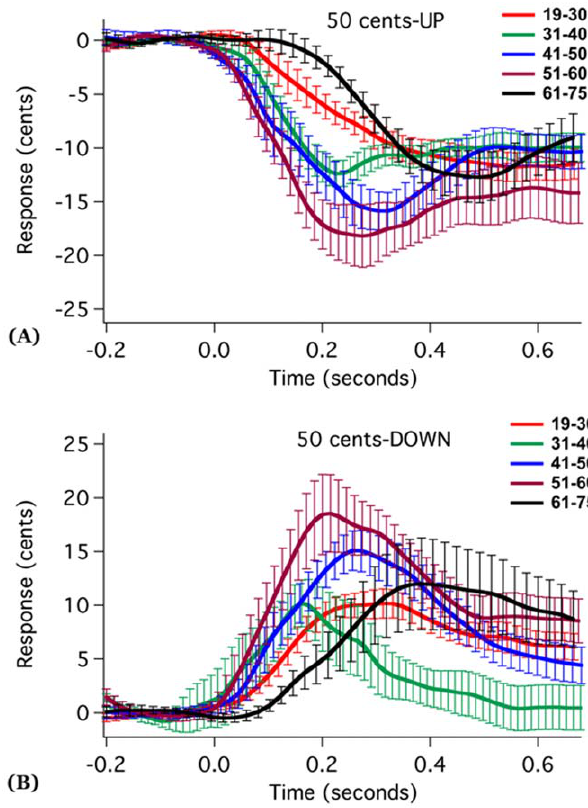
Figure 3. Grand averaged vocal responses over all subjects to upward (A) and downward (B) 100 cents pitch-shifted stimuli as a function of age. Solid lines represent average F 0 contour and vertical bars represent the standard errors of averaged traces.